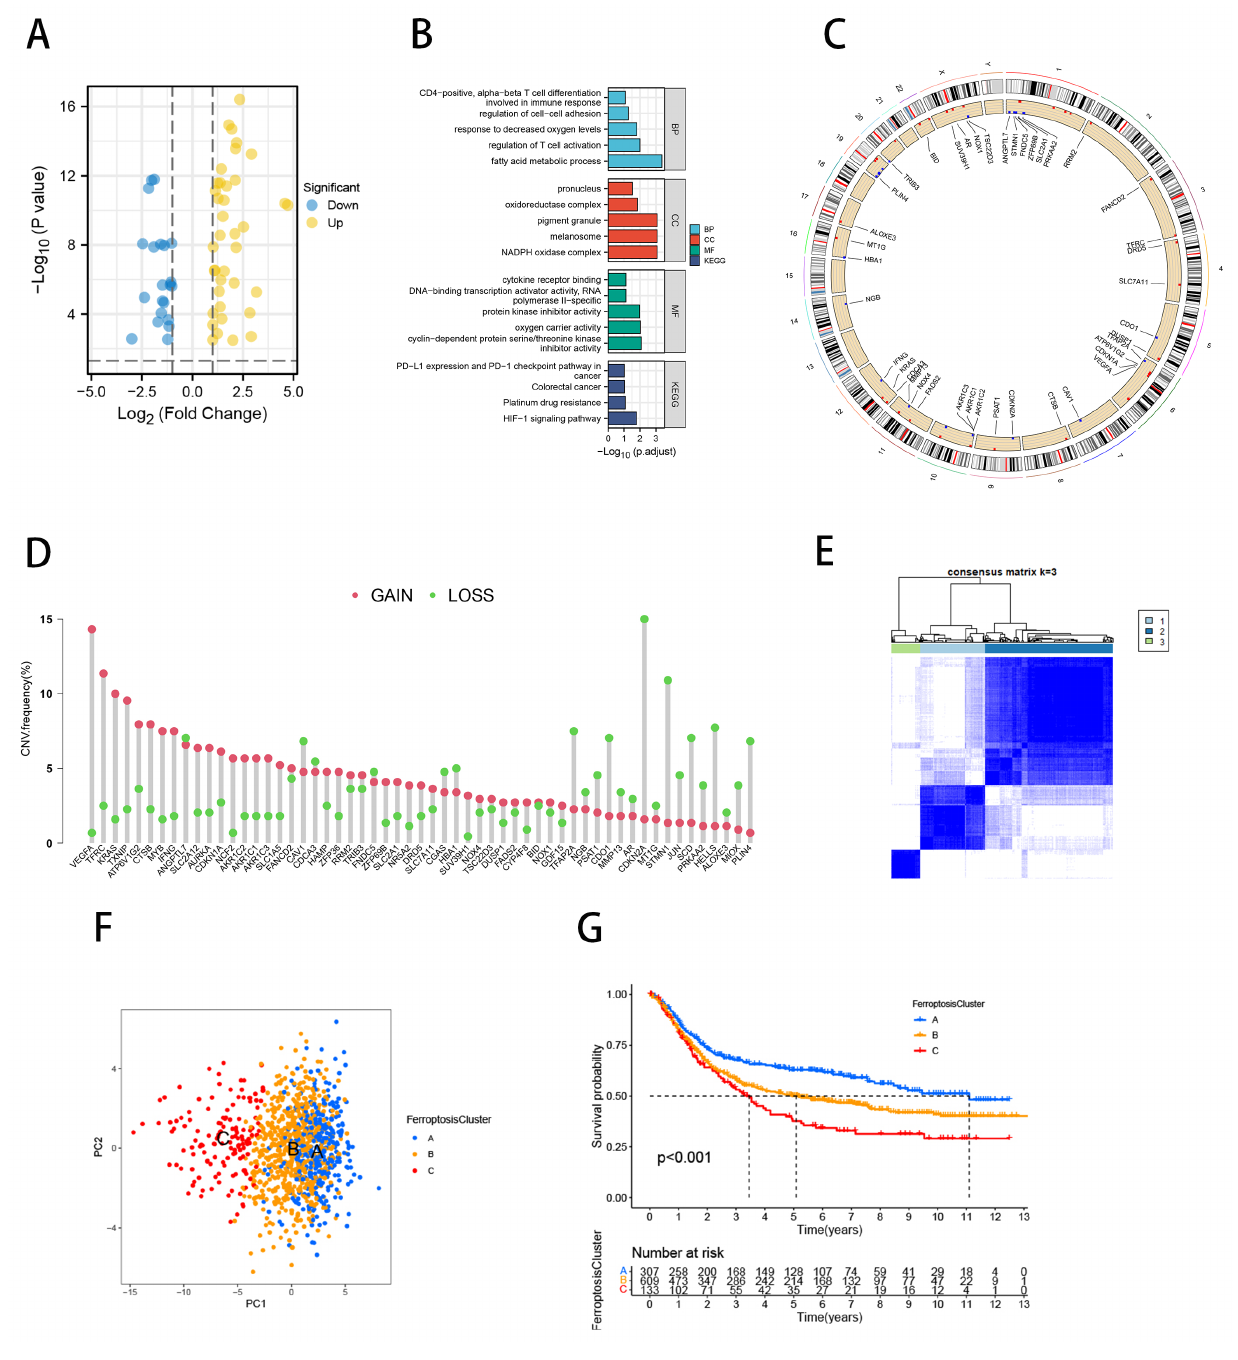
Figure 1. Identification of ferroptosis molecular subtypes. ( A ) Volcano plot demonstrating the differential expression of 59 ferroptosis-related genes in the TCGA-STAD cohort between tumors and adjacent non-tumor tissues. ( B ) Functional enrichment analysis of ferroptosis-related genes with differential expression. ( C ) CNV alteration sites of 59 ferroptosis-related genes. ( D ) CNV alterations of 59 ferroptosis-related genes. Column height indicates alteration frequency; green dots indicate deletions and red dots indicate amplifications. ( E ) The consensus cluster analysis divided the tumor samples into multiple subgroups, with the optimal K value = 3 (k is the number of subgroups divided). Clustering algorithm = K means method. ( F ) PCA of the mRNA expression profiles of FRGs from the GC samples confirmed the three clusters, A (blue), B (yellow) and C (red). ( G ) Kaplan–Meier survival curves for the three molecular clusters, A (blue), B (yellow) and C (red).